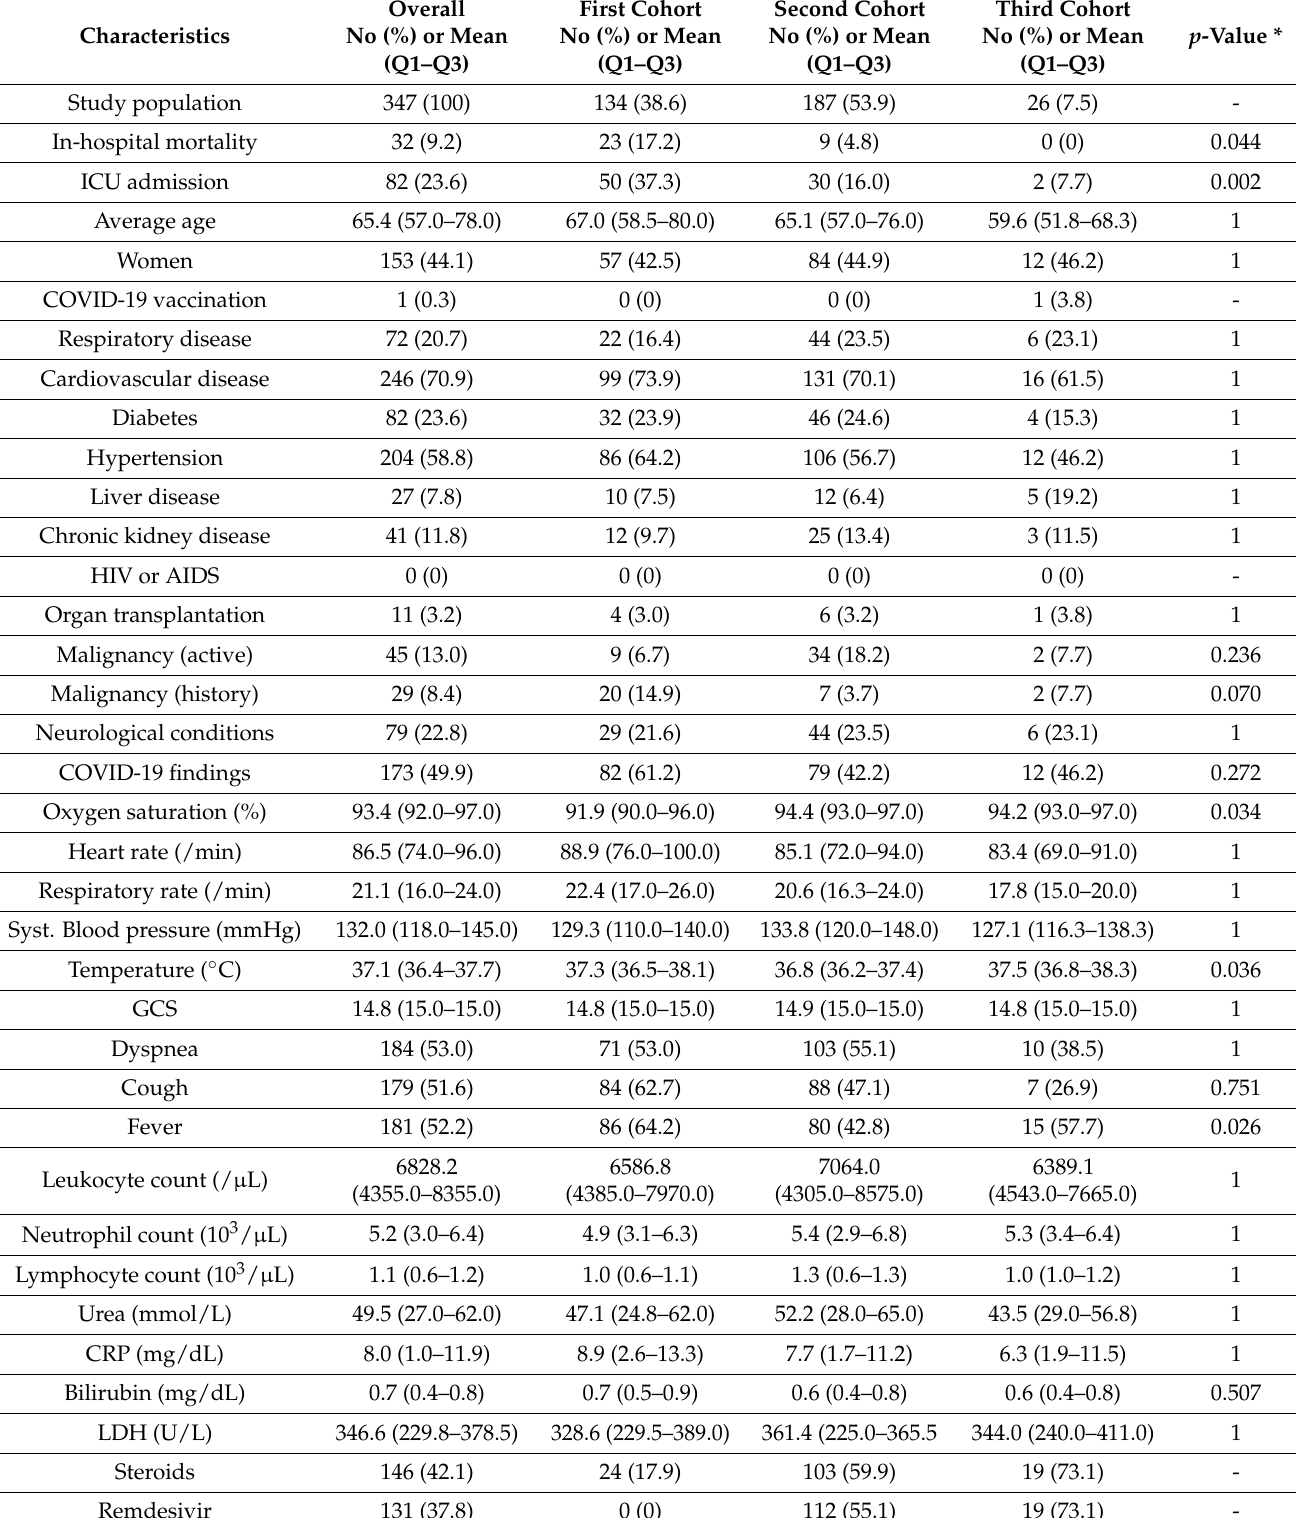
Table 3. Characteristics of study